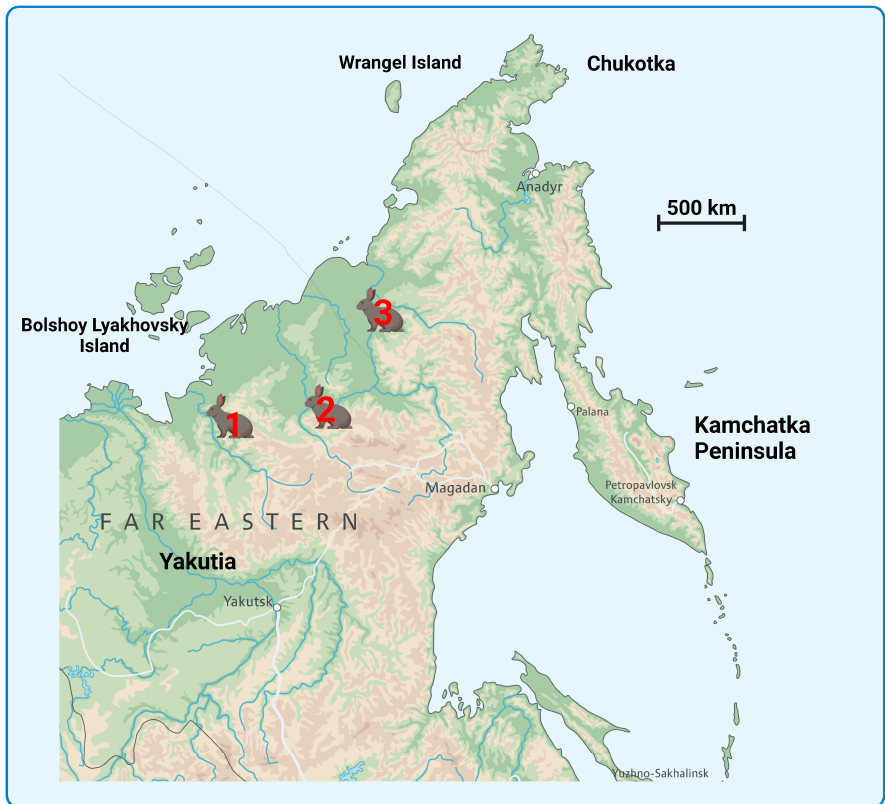
Figure 1. Map showing the sampling sites of Don-hare specimens used in this study. The Don-hare specimen description is presented in Table 1. (1) Specimens Z1 (Yn-3/16) and Z3 (MM-F29); (2) Specimens Z4 (MM-F51) and Z43 (GM-7133); (3) Specimen Z5 (MM-F53).